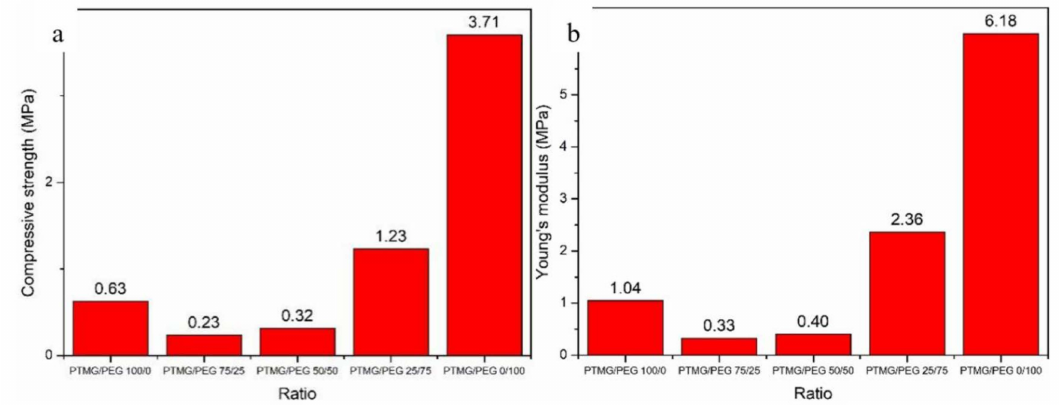
Figure 6. ( a ) Compressive stress (stain of 60%) and ( b ) Young’s modulus of PTMG / PEG porous sca ff olds.